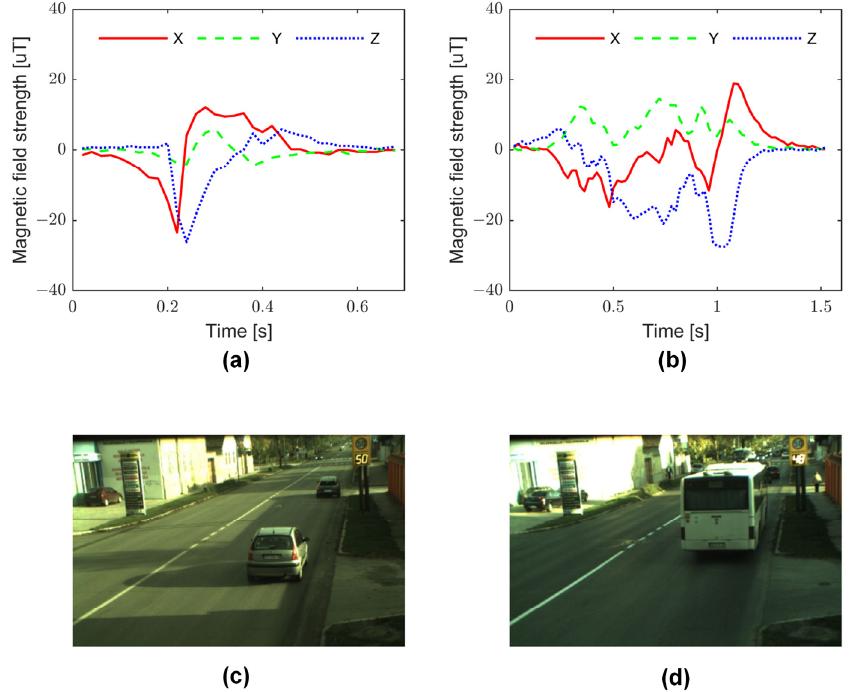
Figure 2. Measured signals on the three sensor axes when a car ( a ) and a bus ( b ) are passing above the sensor, and the corresponding images of the vehicles ( c , d ).